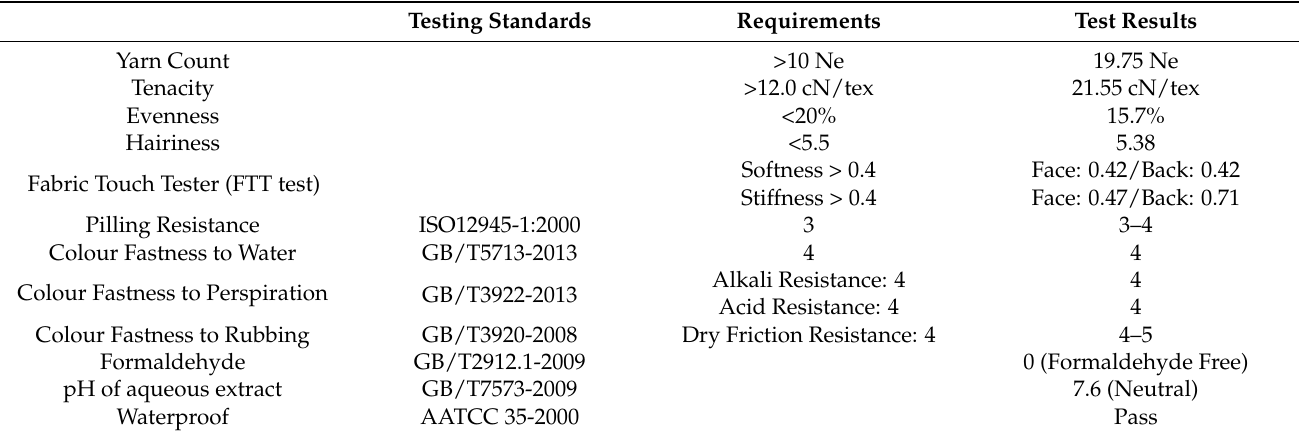
Table 1. Physical test results.